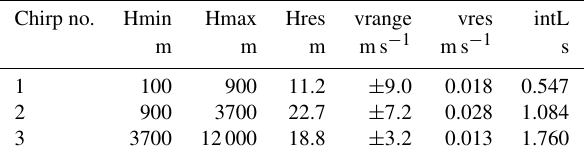
Table 1. Main parameters of the chirps used by the cloud radar. Hmin, Hmax and Hres are minimum, maximum and resolution of the height, vrange and vres are velocity range and resolution, re- spectively, and intL is the integration time over each chirp. Chirp no. Hmin Hmax Hres vrange